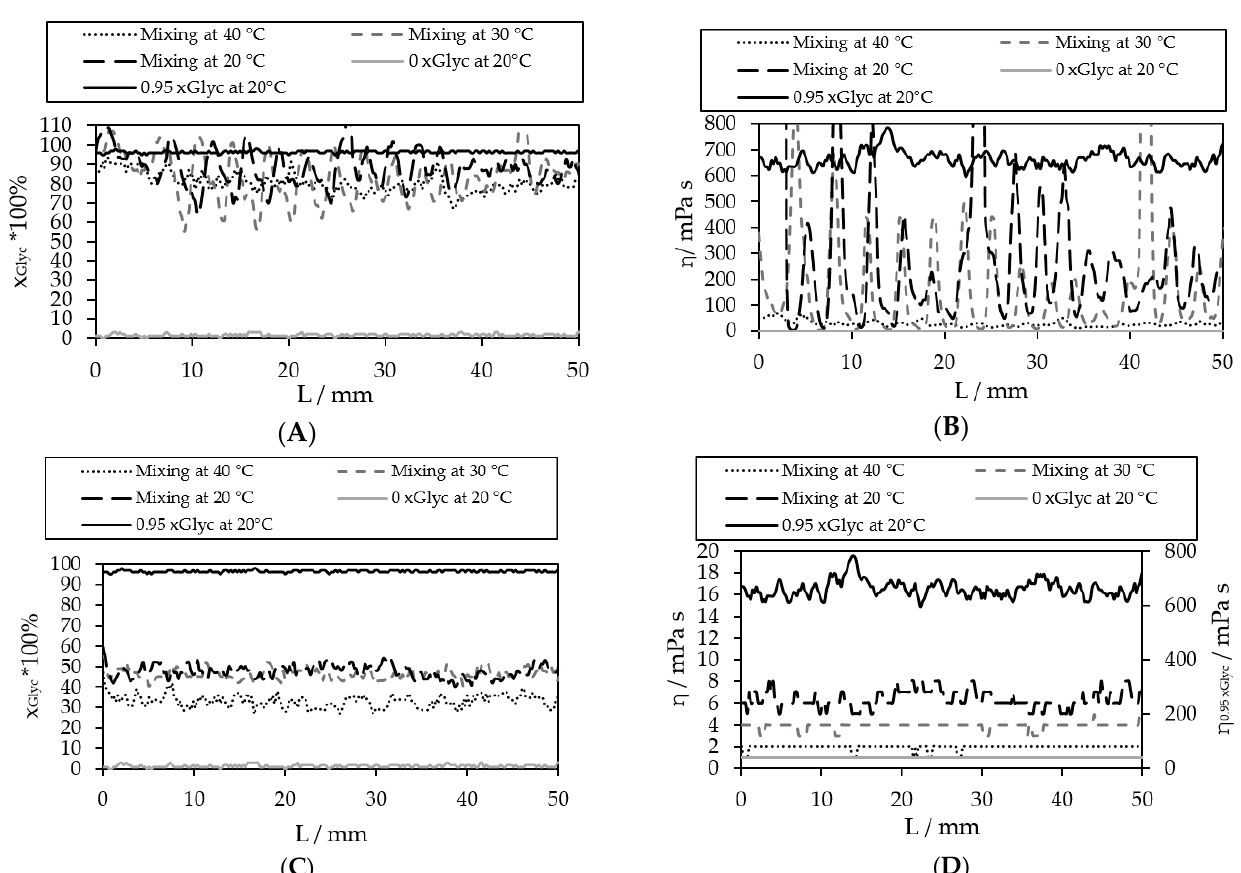
Figure 12. The trend in the channel (as in Figure 9) for the first instance at high viscosity difference ( A , B ), for concentration in mass fraction image ( A ) and viscosity ( B ), and slight viscosity difference ( C , D ) for concentration x Glyc images ( C ) and viscosity images ( D ).